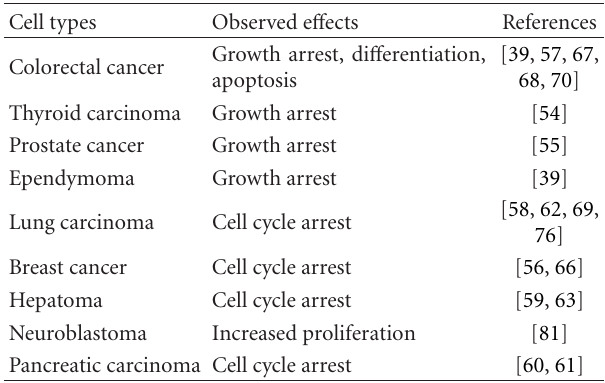
Table 2: E ff ects of TZD administration on human cell lines derived from di ff erent